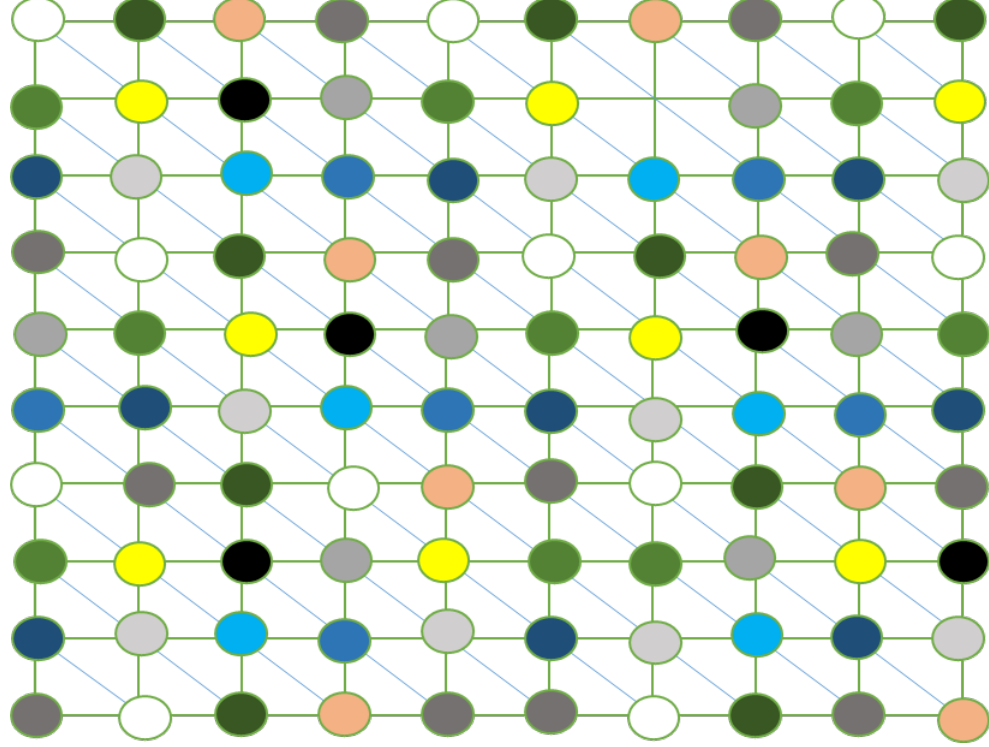
Figure 12. A 10 × 10 matrix cellular grid colored using the L(3,1) coloring. Table 1. Vertex numbering of the L(3,1) algorithm (for a 10 × 10 matrix) with n row and m column.